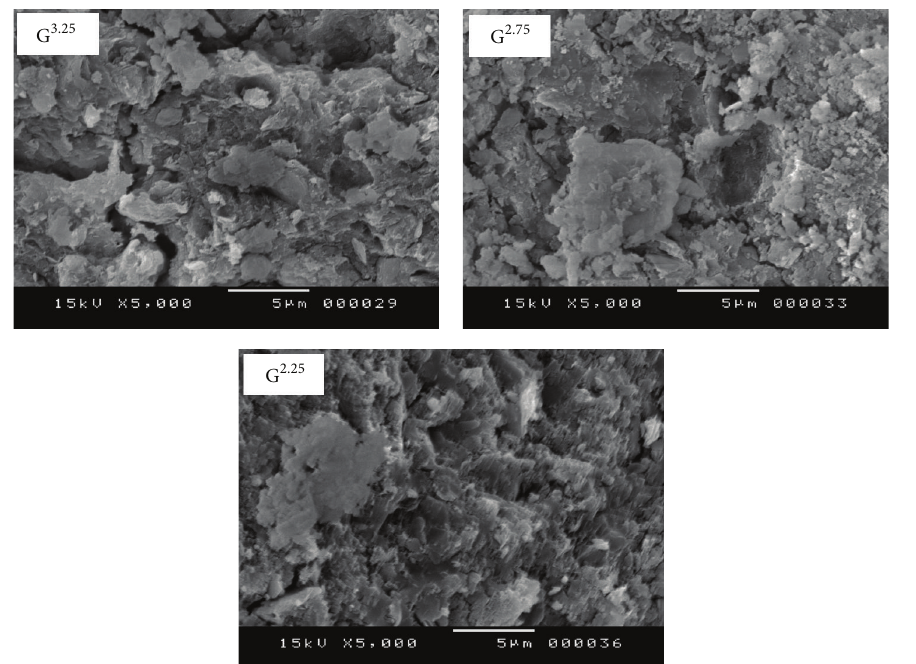
Figure 6: SEM microcrographs of phosphoric acid-based geopolymers at different Si/P molar ratios.